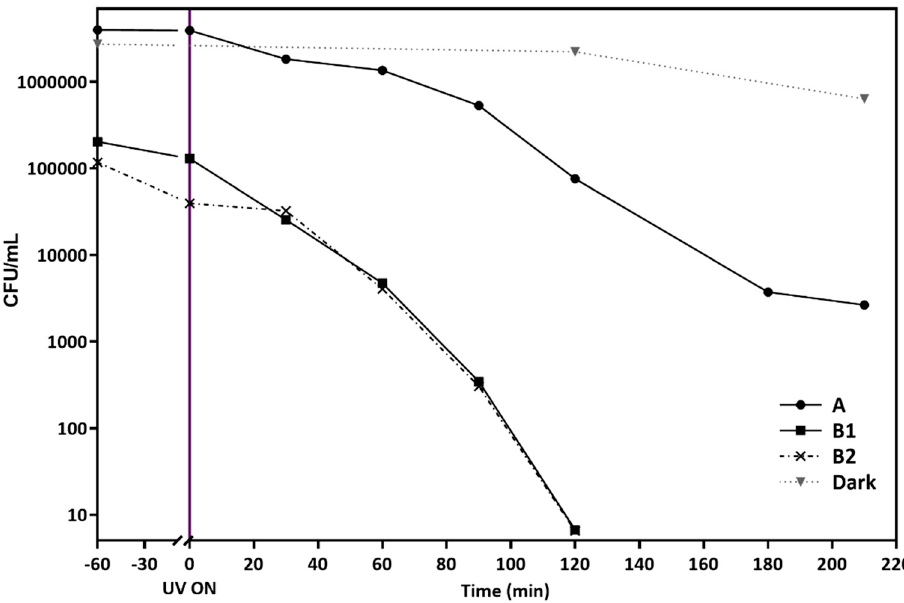
Figure 6. Inactivation of E. coli starting from 10 6 CFU/mL ( A ) and 10 5 CFU/mL ( B1 and B2 ) as well as dark control; all in 1 L and 380 cm 2 Ce-ZnO-coated discs with 38 W UVA.